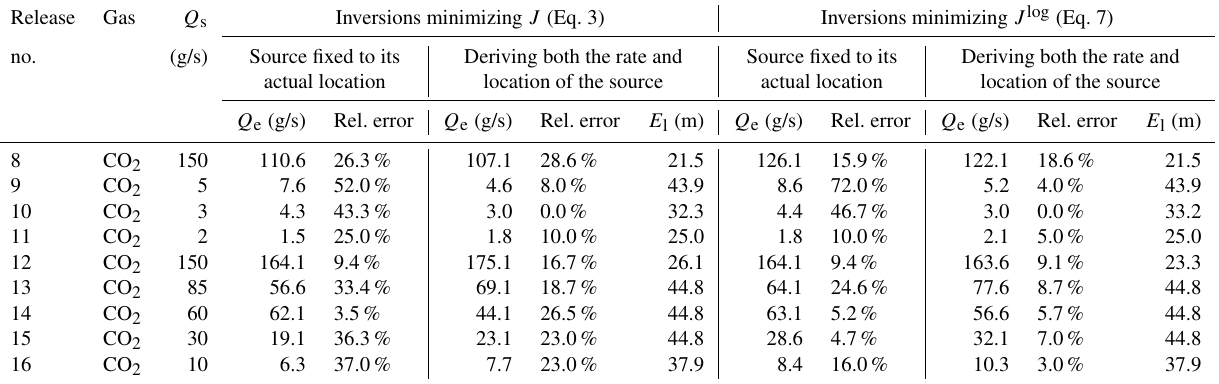
Table 4. Summary of results from the inversion with comparisons between the actual and inverted source location and rates for CO 2 releases. Release Gas Q s Inversions minimizing J (Eq. 3) Inversions minimizing J log (Eq. 7) no. (g/s) Source fixed to its Deriving both the rate and Source fixed to its Deriving both the rate and actual location location of the source actual location location of the